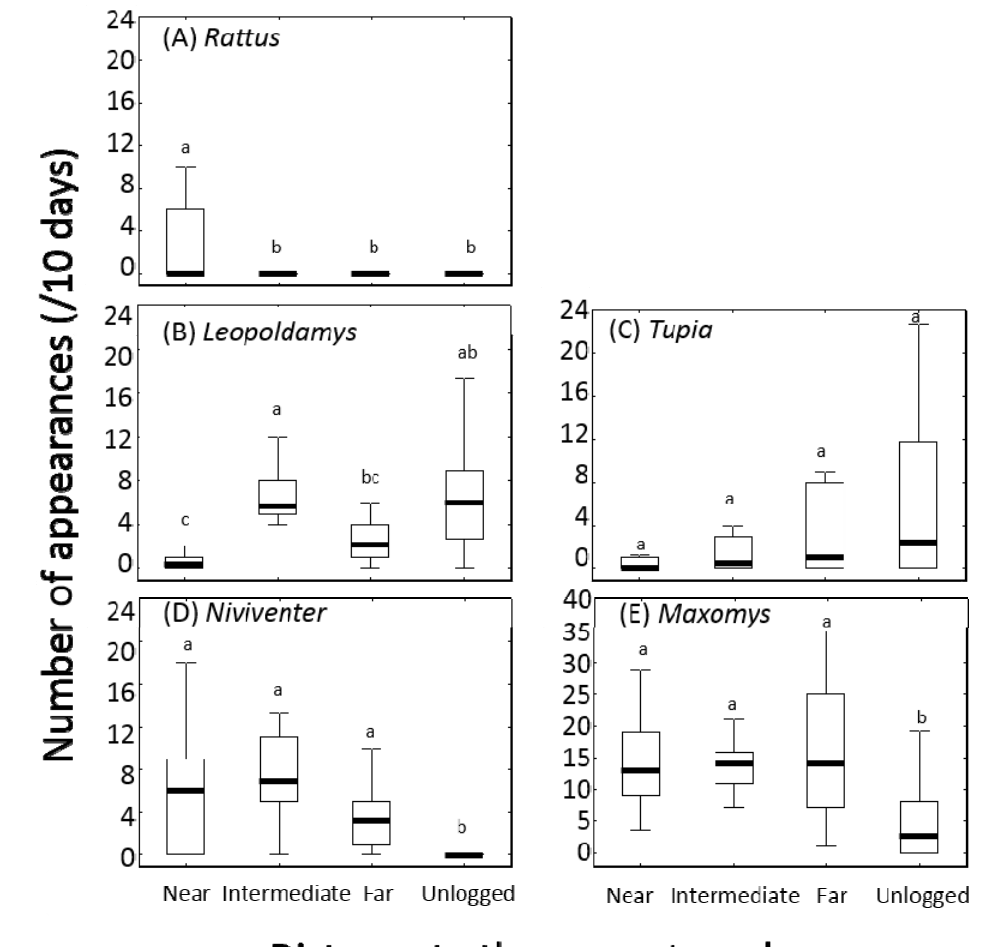
Figure 5. The appearances of small mammals in three distance classes, near (distance from logging road, D < 100 m), intermediate (100 m ≤ D < 200 m), and far ( D ≥ 200 m) from the logging road in the logged forest in Temengor Forest Reserve for ( A ) Rattus species; ( B ) Leopoldamys sabanus ; ( C ) Tupia glis ; ( D ) Niviventer cremoriventer ; and ( E ) Maxomys species. The appearances of small mammals in unlogged forest are also shown (unlogged). We counted a series of conspecific appearances in 30 minutes as a single appearance. The number of appearances indicates the total number of appearances for a genus over 10 days per camera. Data are shown with a median value (thick black line), 25th and 75th percentiles (upper and lower boundary of box) and maximum and minimum values (whiskers) of appearances for a genus at 10 cameras within a distance class from the logging road (see Figure 2B). Boxes labeled with different letters differ significantly among sites ( p < 0.05, Pairwise Wilcoxon Test with Holm